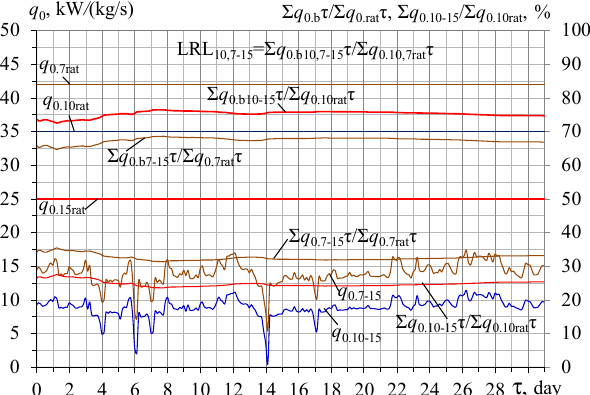
Figure 12. Actual values of refrigeration capacities q 0.10–15 and q 0.7–15 for subcooling air from the threshold values of 15 to 10 and 7 ° С and corresponding relative summarized refrigeration energy consumed in unregulated ranges for subcooling the air ∑ ( q 0.10–15 τ )/ ∑ ( q 0.10rat τ ) and ∑ ( q 0.7–15 τ )/ ∑ ( q 0.7rat τ ), corresponding to relative summarized refrigeration energy consumed in booster regulated ranges for precooling the air ∑ ( q 0.b10–15 τ )/ ∑ ( q 0.10rat τ ) and ∑ ( q 0.b7–15 τ )/ ∑ ( q 0.7rat τ ) to the threshold value of 15 ° С :